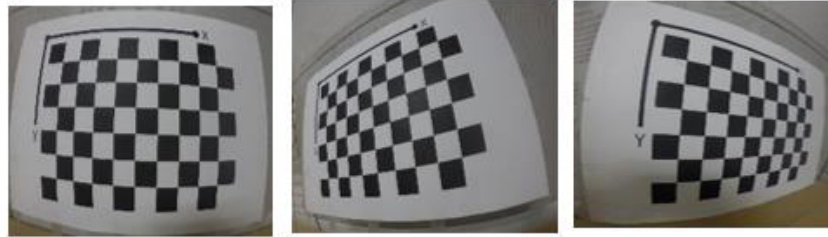
Figure 5. Example images of a checkerboard calibration patterns.